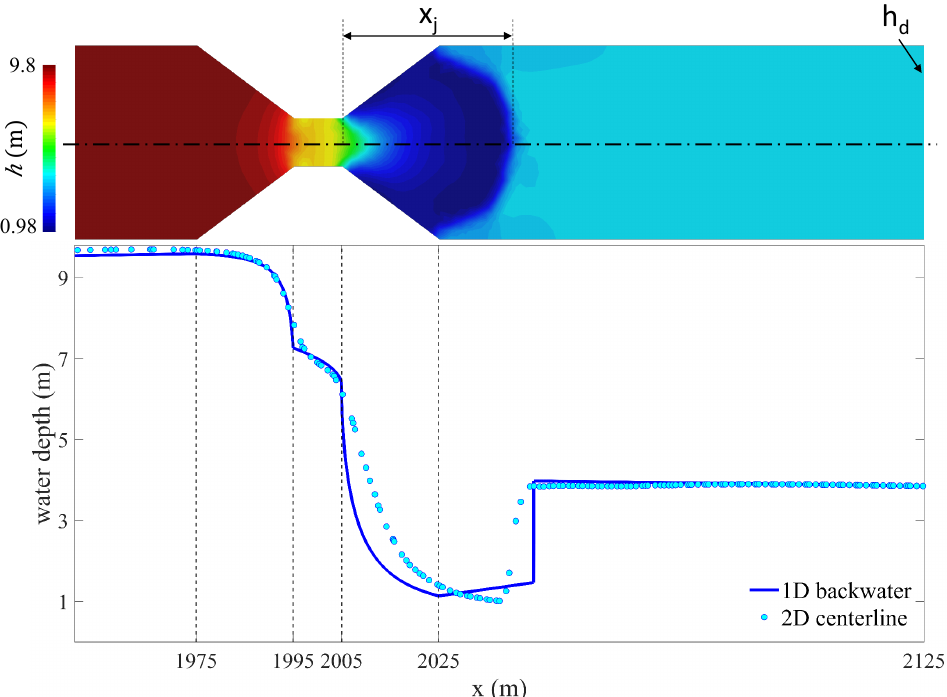
Figure 13. Predicting the jump location downstream of a channel contraction: problem set-up. We consider a long channel with slope S 0 = 0.002, length of 2000 m and width b 1 = 40. A symmetric, contraction reduces the width to a value b 2 over a distance L e = 20 m. We solve steady-state flow for several values of the discharge Q , minimum width b 2 and imposed downstream water depth, h d , and compare the predicted location of the jump, x j , using the 1D theory and the 2D shallow-water Equations (along the channel